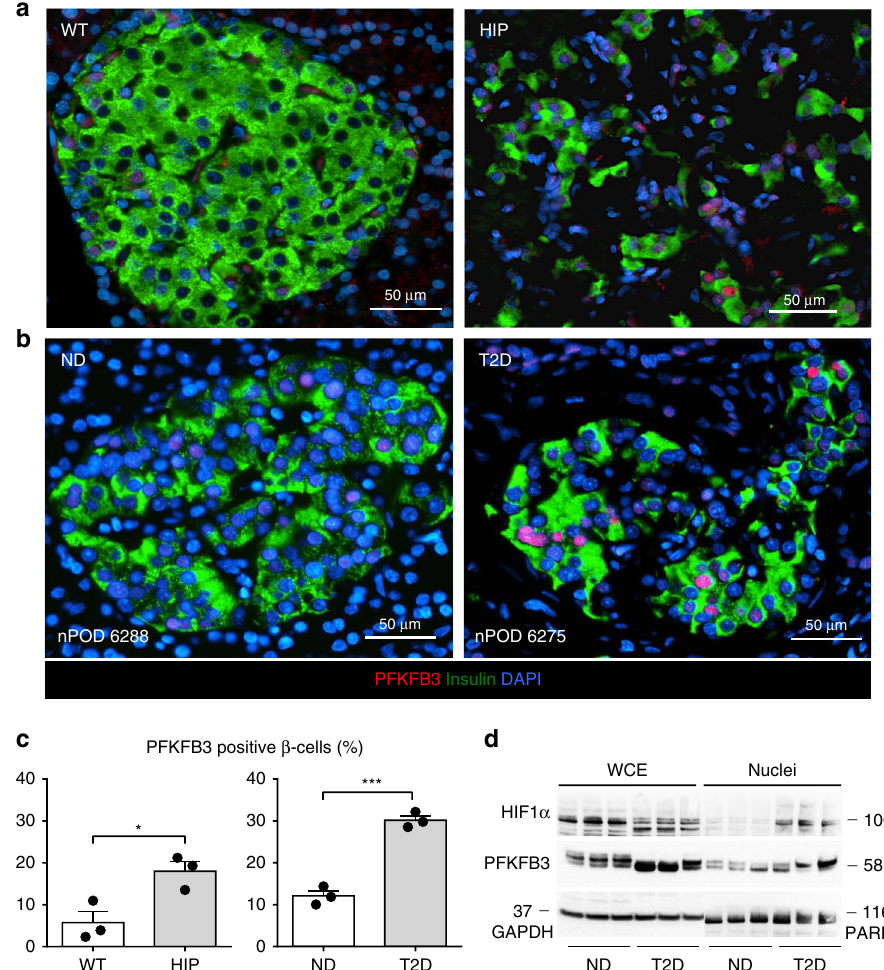
Fig. 2 HIF1 α /PFKFB3 is upregulated in β -cells of HIP rats and humans with type 2 diabetes. Representative immuno fl uorescence images of islets from a WT and HIP rats and b non-diabetic (ND) and T2D patients stained for PFKFB3 (red), insulin (green), and nuclei (blue). c Frequency of PFKFB3 positive β -cells in HIP versus WT rats (left panel) and T2D versus ND patients (right panel). d Representative Western blot of PFKFB3 and HIF1 α levels in nuclear- enriched- and whole cell extracts from non-diabetic (ND) and T2D donor islets. Data are presented as mean ± SEM, n = 3 independent biological samples for each group. Statistical signi fi cance was analyzed by Student t -test (* p < 0.05, *** p <